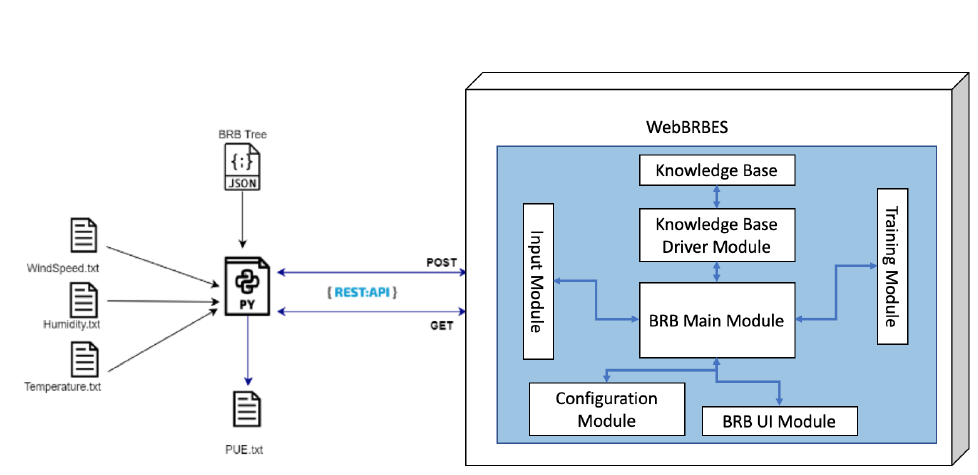
Figure 7. BRBES system